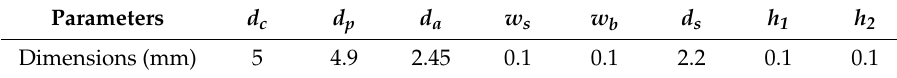
Table 1. Dimensions of geometrical parameters of the DP–EBG structure.